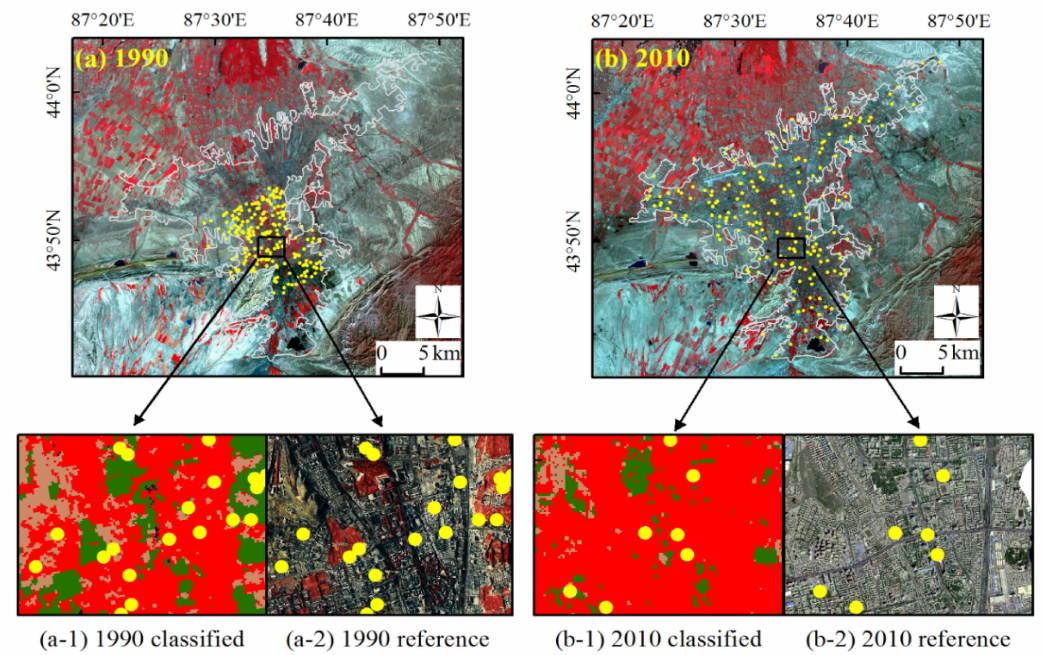
Figure 3. Location of the sampling plots (yellow dots) for accuracy assessments. ( a ) and ( b ) show the Landsat TM images in false color composite (bands 432 (RGB)) in 1990 and 2010, respectively; ( a-1 ) and ( b-1 ) are the land-cover maps developed in this study, for the year 1990 and 2010, respectively; ( a-2 ) and ( b-2 ) are the high-resolution reference images used in the accuracy assessments for the year 1990 and 2000, respectively. Note that our high-resolution aerial photo in 1990 only covered the center of the